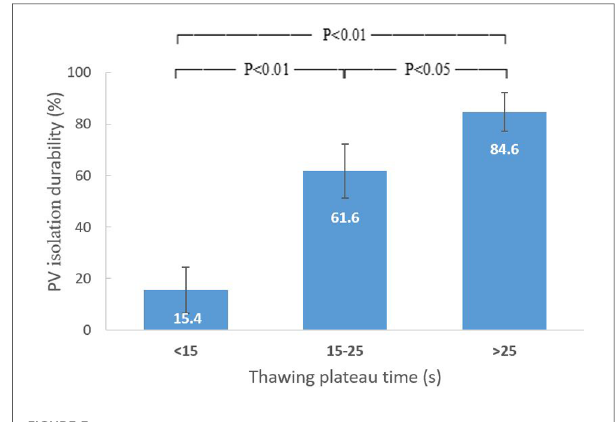
FIGURE 3 Relation between thawing plateau time and durability of PV isolation.